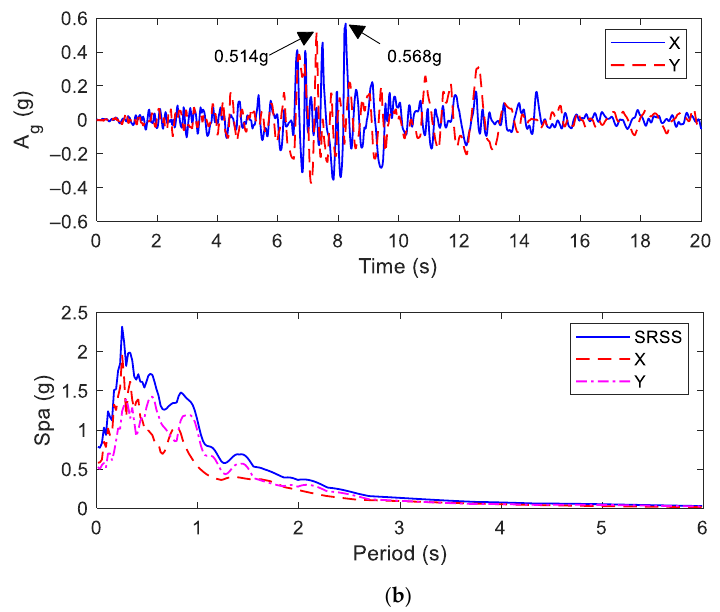
Figure 4. Acceleration time history data and response spectra of the selected ground motions: ( a ) Rinaldi Receiving station and ( b ) LA-Obregon Park station.